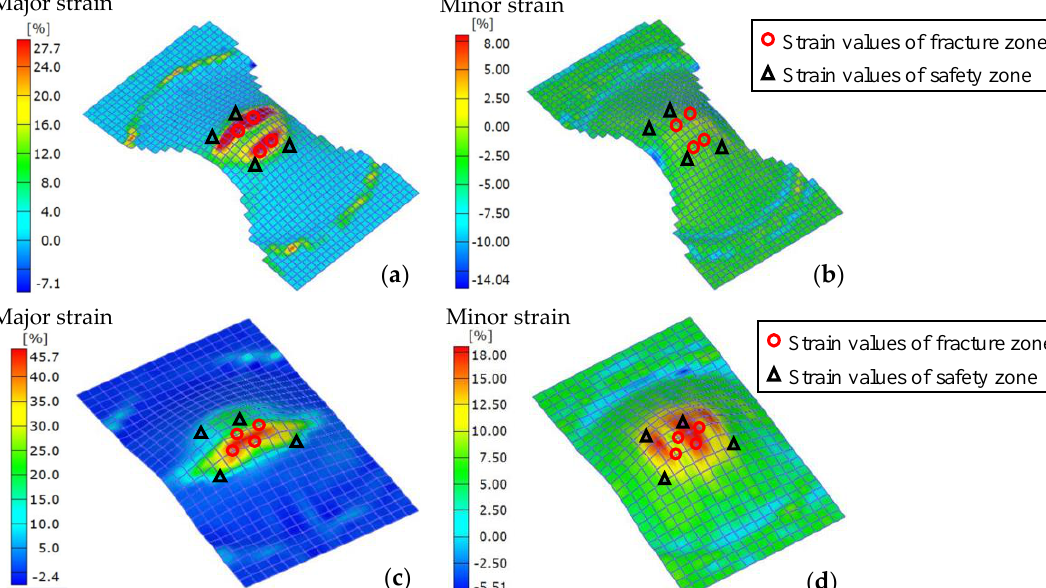
Figure 9. Major and minor strains ’ distributions of specimens in software. ( a ) Major strain distribution with width of 30 mm. ( b ) Minor strain distribution with width of 30 mm. ( c ) Major strain distribution with width of 60 mm. ( d ) Minor strain distribution with width of 60 mm.